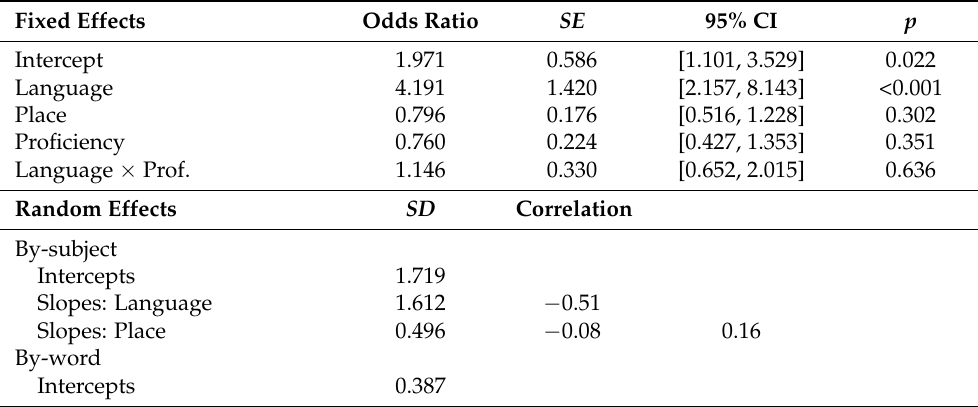
Table 2. Summary of logistic mixed-effects model fit to the voiced stop data.